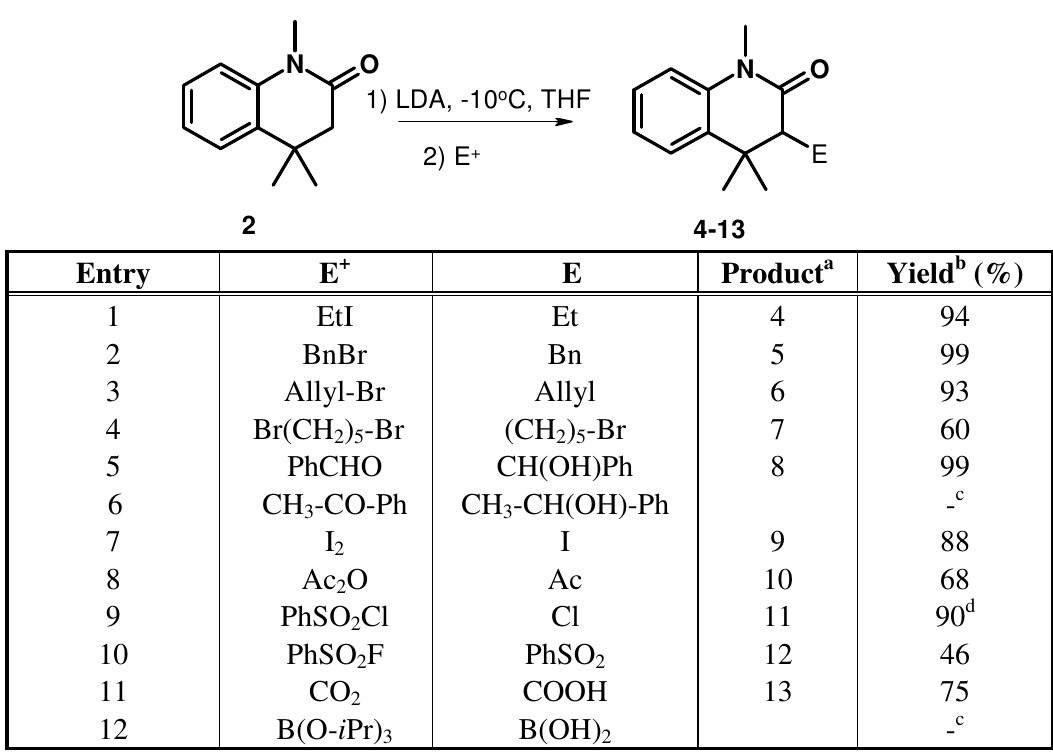
Table 1. Lithiation and Electrophilic Substitution of 2